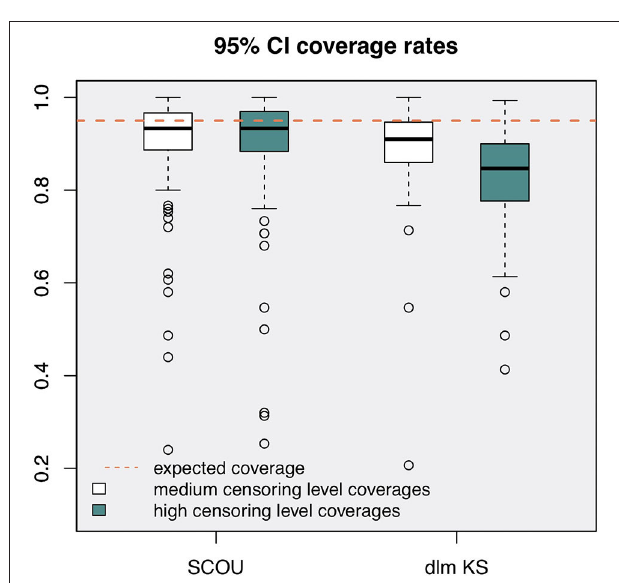
FIGURE 6 | Coverage rates of the prediction intervals for the prediction of X , with 16 % and 31 % of censored data (respectively white and cyan